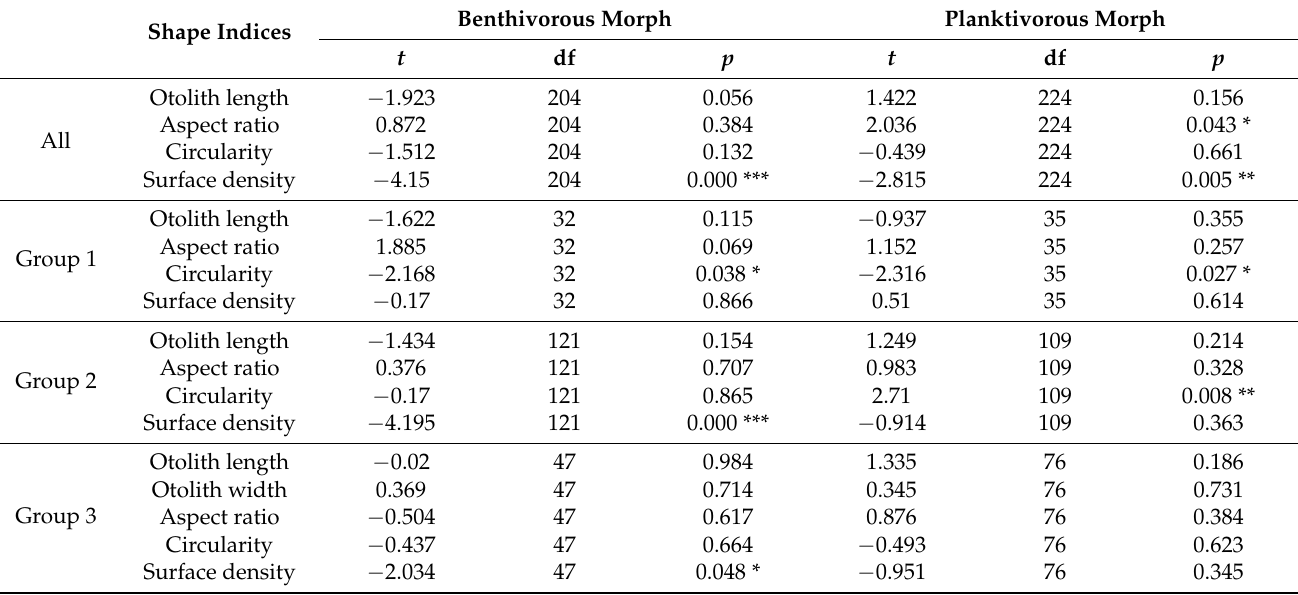
Table 3. Results of Student’s t -test of sexes of each morph based on otolith shape indices which contained the combination of all TL groups, first TL group, second TL group, and third TL group,